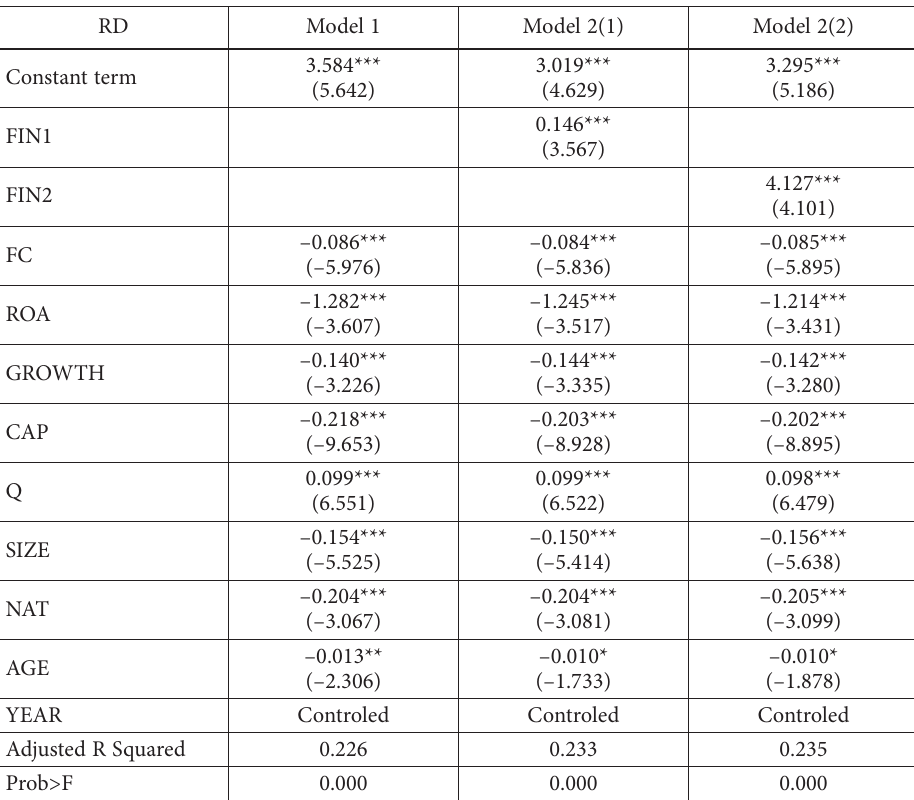
Table 8. Results of Model 1 and